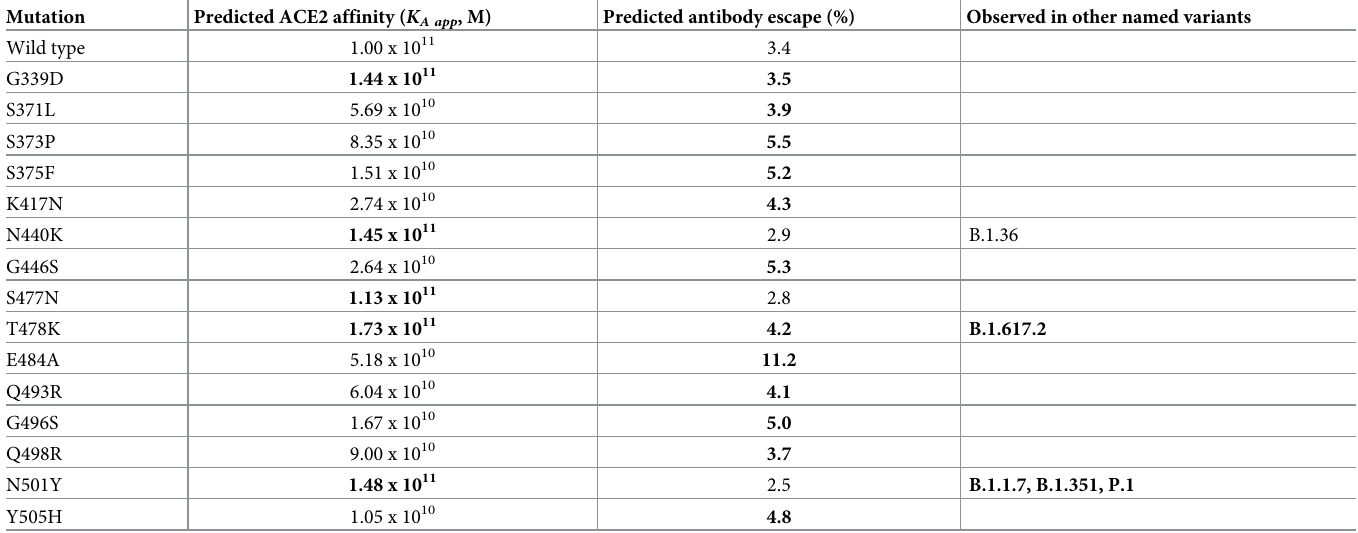
Table 2. Predicted impacts of individual RBD mutations in the Omicron (B.1.1.529) variant on ACE2 affinity and human antibody escape. Predictions of increased ACE2 affinity or human antibody escape are indicated by bold values. Named variants in bold are current and former Variants of Concern. Mutation Predicted ACE2 affinity ( K , A app